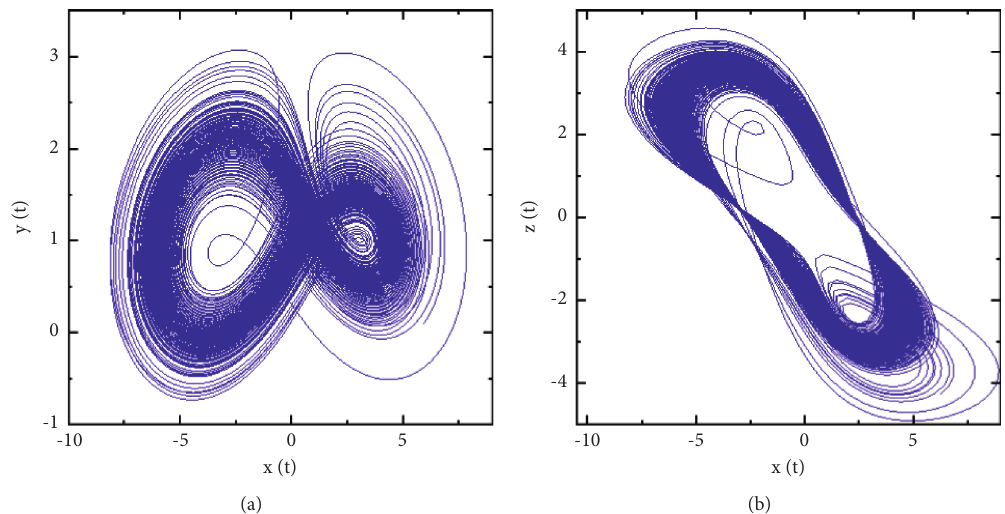
� 1 , q � 0 . 87 , and q � 1 projected onto (a) the x − y phase plane and 1 2 3